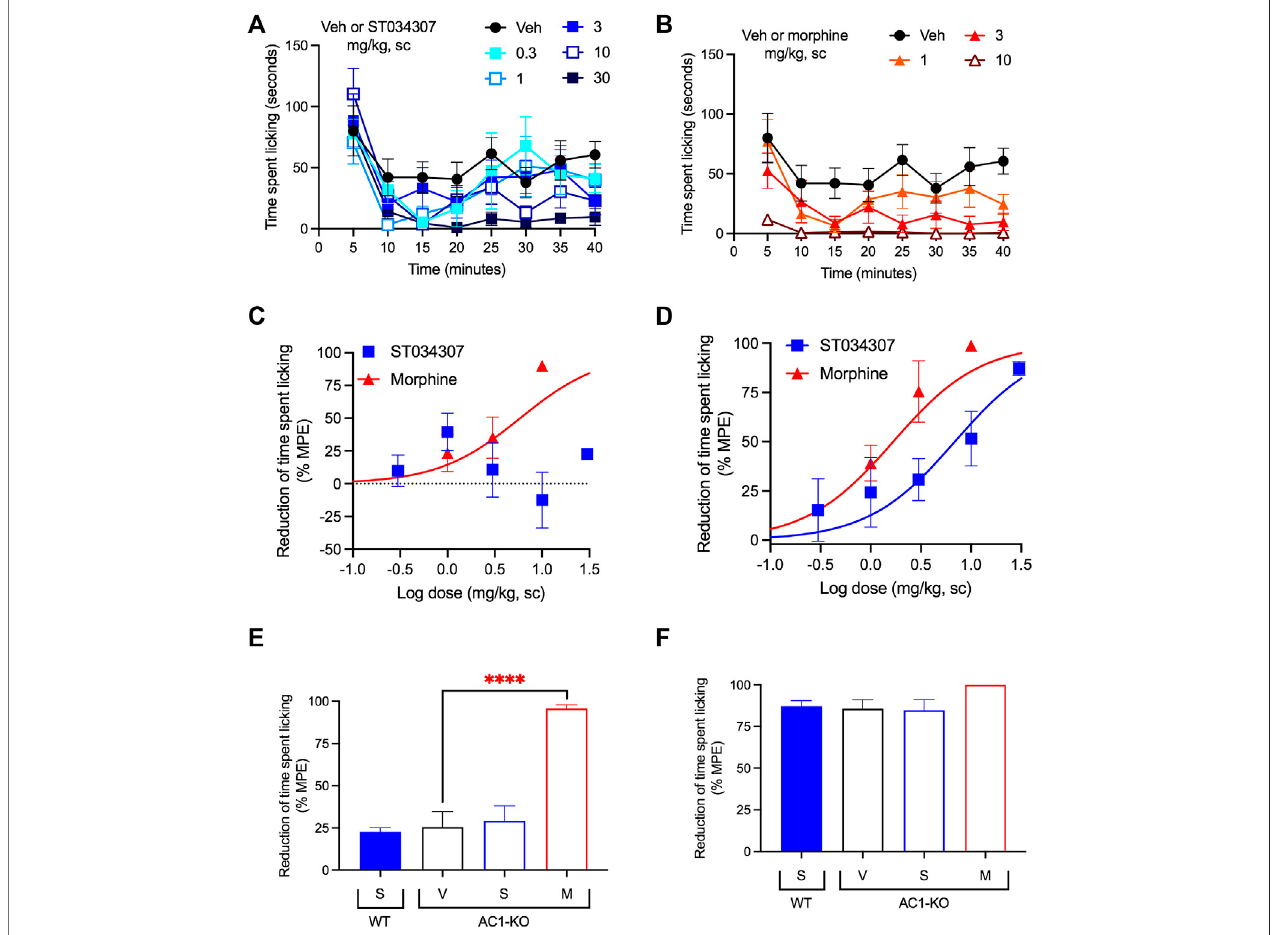
FIGURE1| ST034307relievesin fl ammatorypaininmice. (A) DifferentdosesofST034307reducepawlickingbehaviorcausedbyanintraplantarinjectionwith5% formalin. (B) Different doses of morphine reduce paw licking behavior caused by an intraplantar injection with 5% formalin. (C) Dose-response curves ofthe sum of time spent licking the paw during the fi rst 10 min of the graphs in (A) and (B) . Vehicle ’ s response was set as 0% and the maximal possible effect (0) to 100%. (D) Dose- responsecurvesofthesumoftimespentlickingthepawduringtheperiodinbetweenminute16andminute40ofthegraphsin (A) and (B) .Vehicle ’ sresponsewas setas0%andthemaximalpossibleeffect(0)to100%. (E) Reductionoftimespentlickingtheinjectedpawinwild-type(WT)andinAC1-KOmicetreatedwithvehicle(V), 30 mg/kgST034307(S),or10 mg/kgmorphine(M)duringthe fi rst10 minoftheexperiment. (F) Reductionoftimespentlickingtheinjectedpawinwild-type(WT)andin AC1-KOmicetreatedwithvehicle(V),30 mg/kgST034307(S),or10 mg/kgmorphine(M)duringtheperiodinbetweenminute16andminute40oftheexperiment.ForE and F vehicle ’ s response in wild-type mice was set to 0% and zero to 100%. Data in all graphs represent the average ±S.E.M., N = 6 – 8. **** p < 0.0001 in one-way ANOVA with Dunnett ’ s